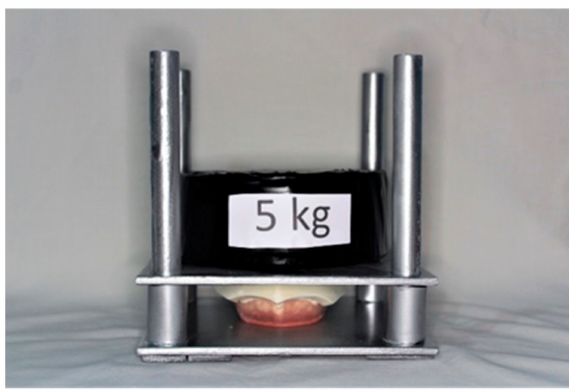
Figure 3. Standardized testing device for impression